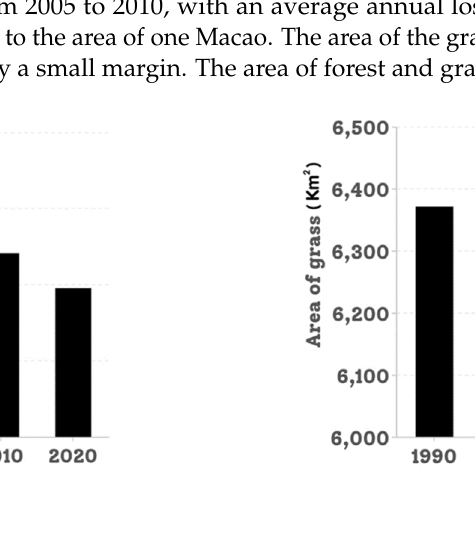
Figure 7. Vegetation area varies with year ( a ) changes in forest ( b ) changes in